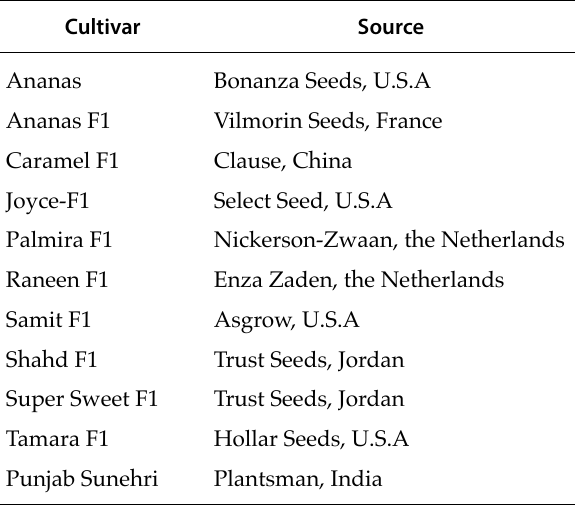
Table 1. Sources of 11 muskmelon cultivars used in this